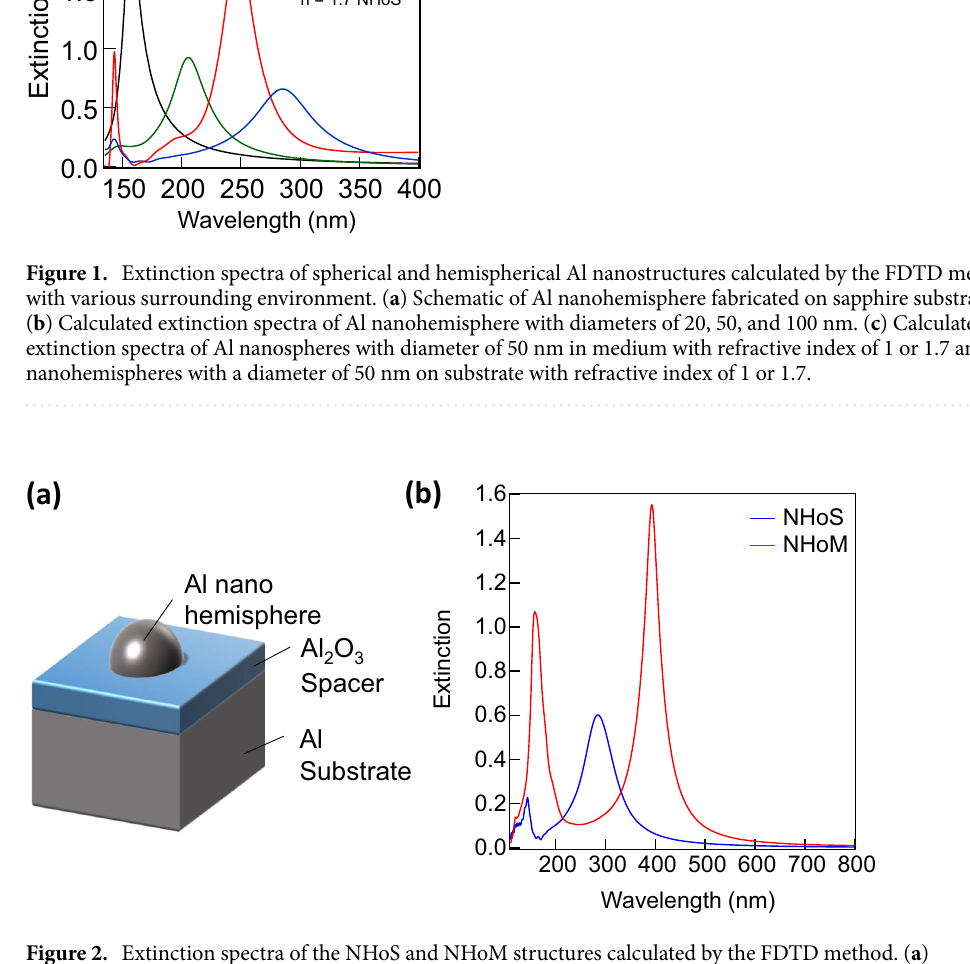
Figure 2. Extinction spectra of the NHoS and NHoM structures calculated by the FDTD method. ( a ) Schematic of NHoM structure. ( b ) Calculated extinction spectra of Al nanohemisphere with diameter of 50 nm, and NHoM structure with diameter of 50 nm and Al 2 O 3 spacer of 5 nm. The extinction spectrum of the NHoM structure is clearly visible even at wavelengths below 200